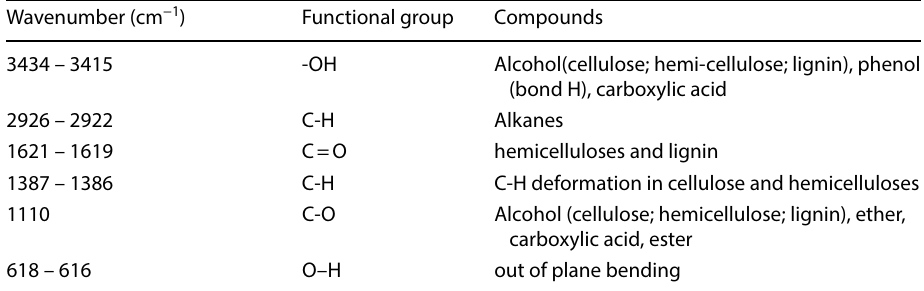
Table 7 Characteristic bands for a functional group of